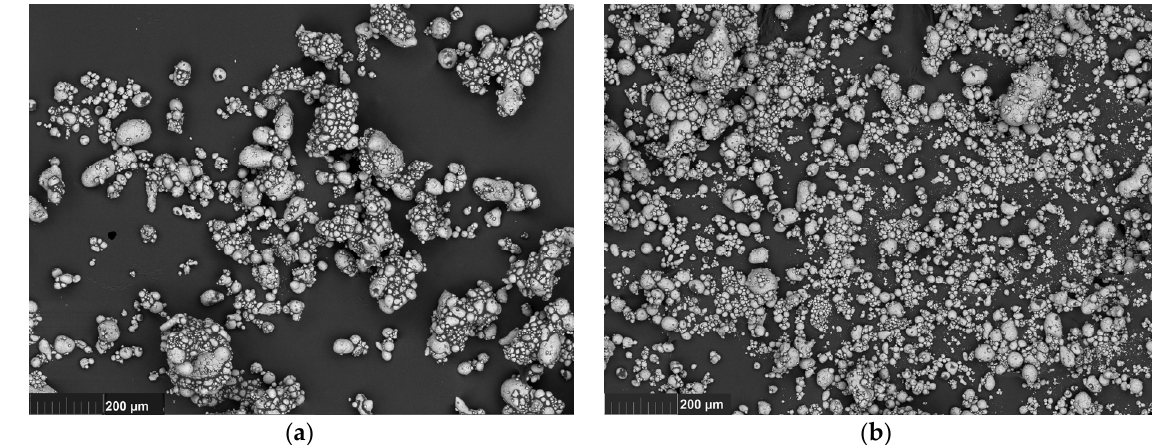
Figure 3. Microphotographs of 80 vol.% suspension with the 20% ( a ) and 40% ( b ) content of smaller particles.